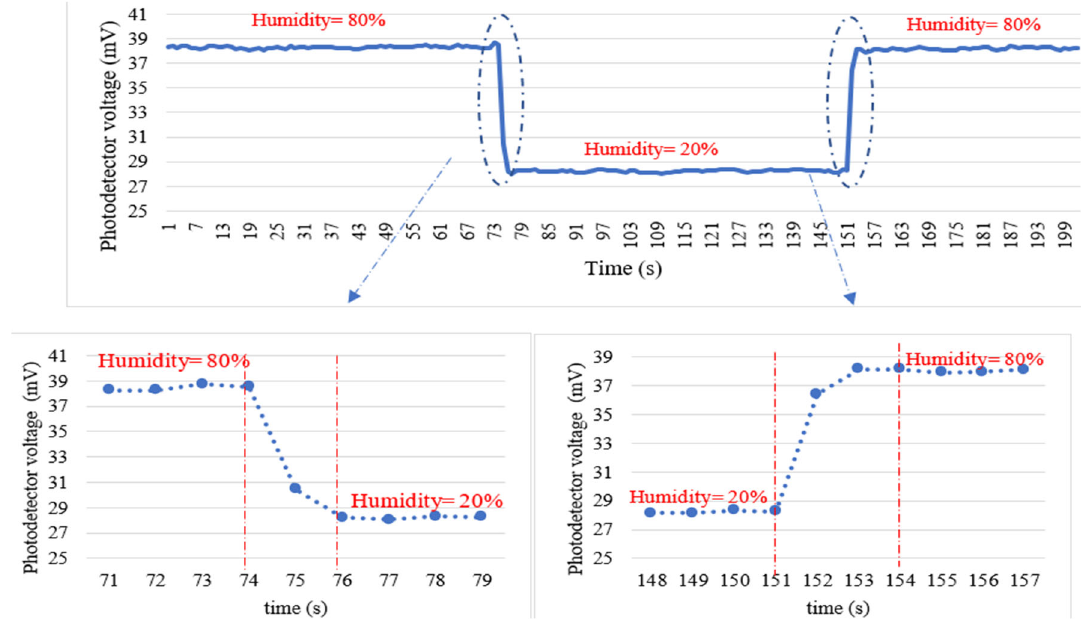
Figure 10. Response of the U ‐ bent fiber coated with the ZnO nanoparticles to a sudden change in humidity. Table 3. Humidity sensors working based on the evanescent-wave surface plasmon excitation principle reported in the